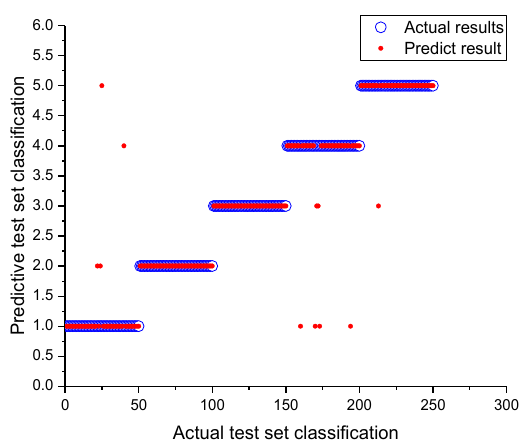
Figure 11. Classification results of PNN.